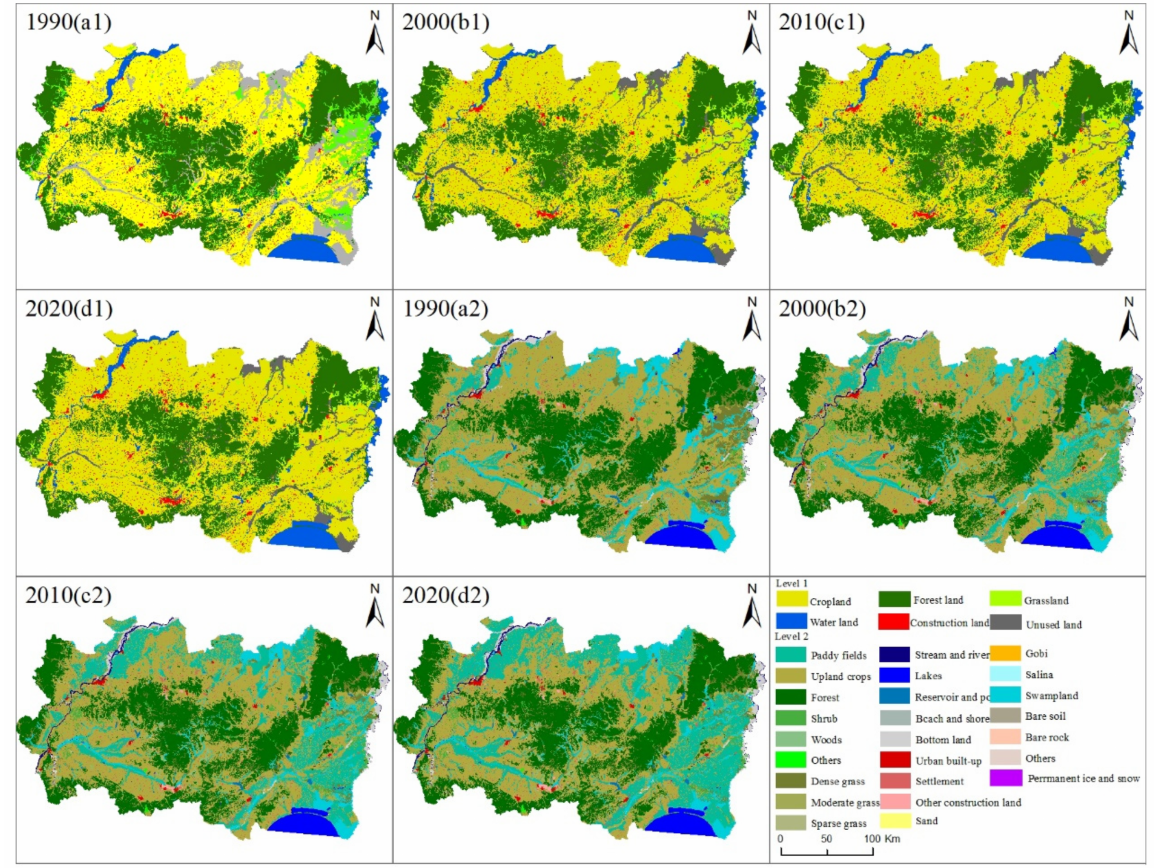
Figure 3. Spatial evolution map of land use in the study area in the years of 1990, 2000, 2010 and 2020, respectively. Note: Level 1 of land types was ( a1 – d1 ) and the corresponding level 2 was ( a2 – d2